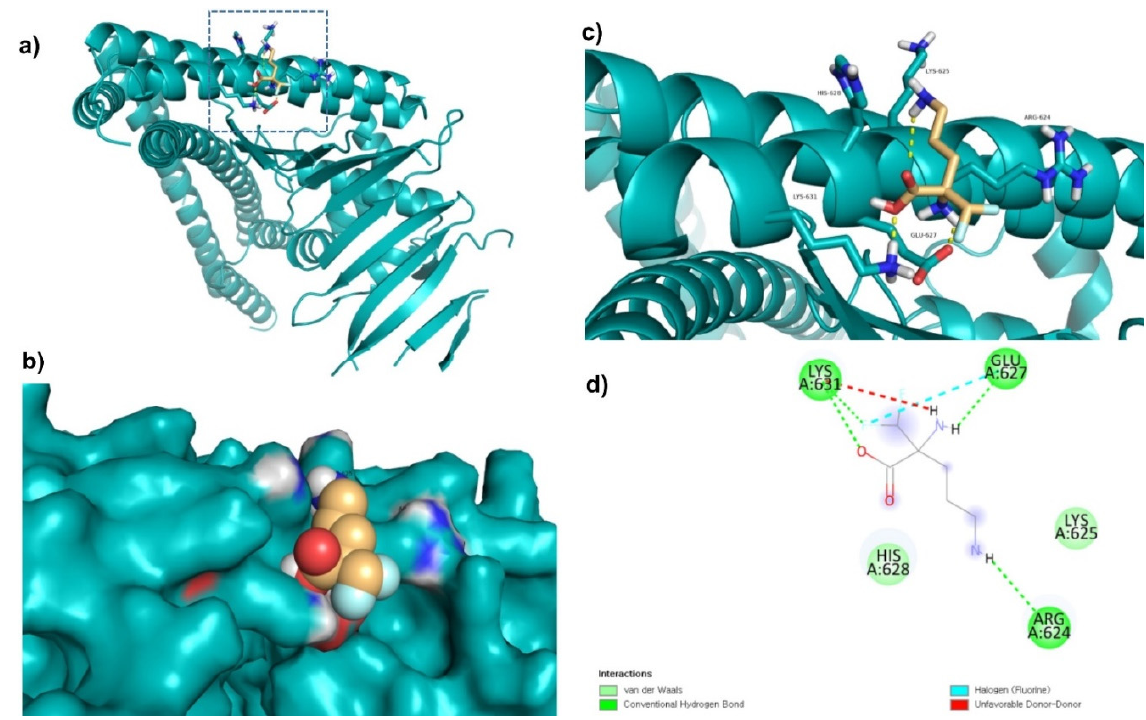
Figure 4. Visualization and surface view of DFMO in active site of CagA protein ( a , b ). Three-dimensional ( c ) and 2D ( d ) view of CagA residue interacting with DFMO.